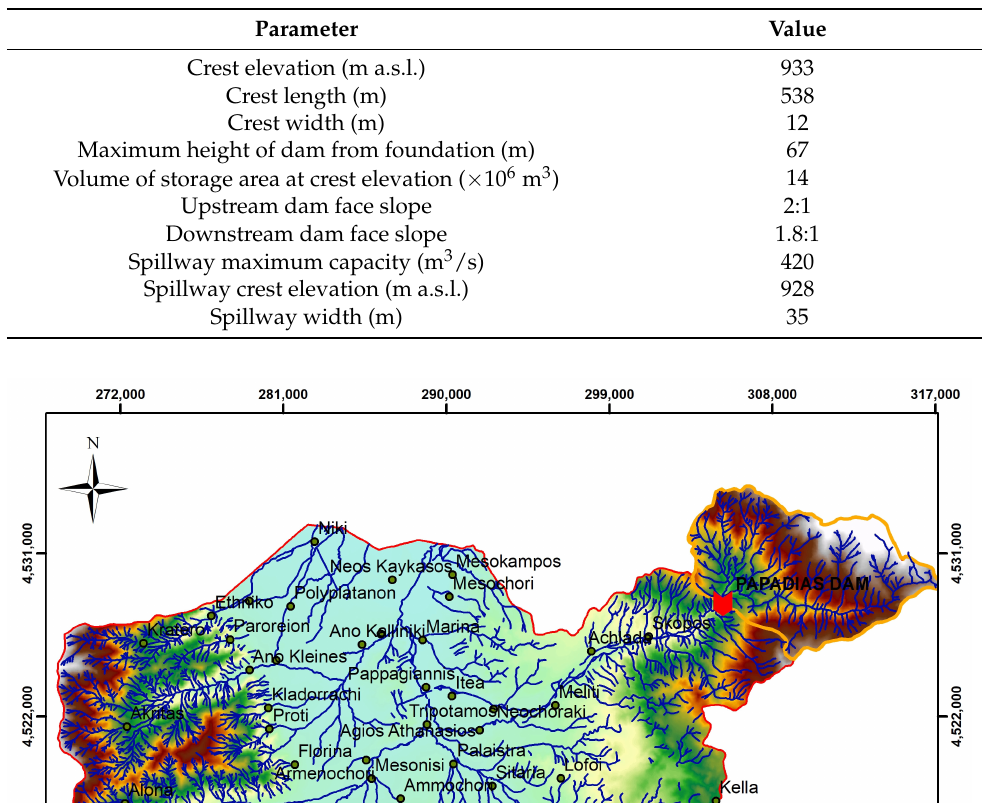
Table 2. Papadia dam technical characteristics.